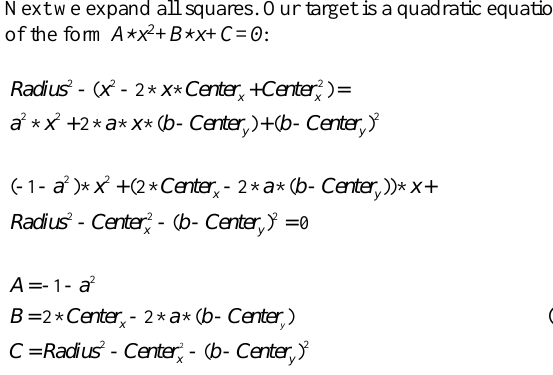
Figure 6. A Voronoi map of the Dutch language area after being processed with the cell edge clipping method described in this paper. The smaller cells after edge clipping are a better approximation of the dialect areas than the cells associated with the rectangular bounding box displayed in Figure